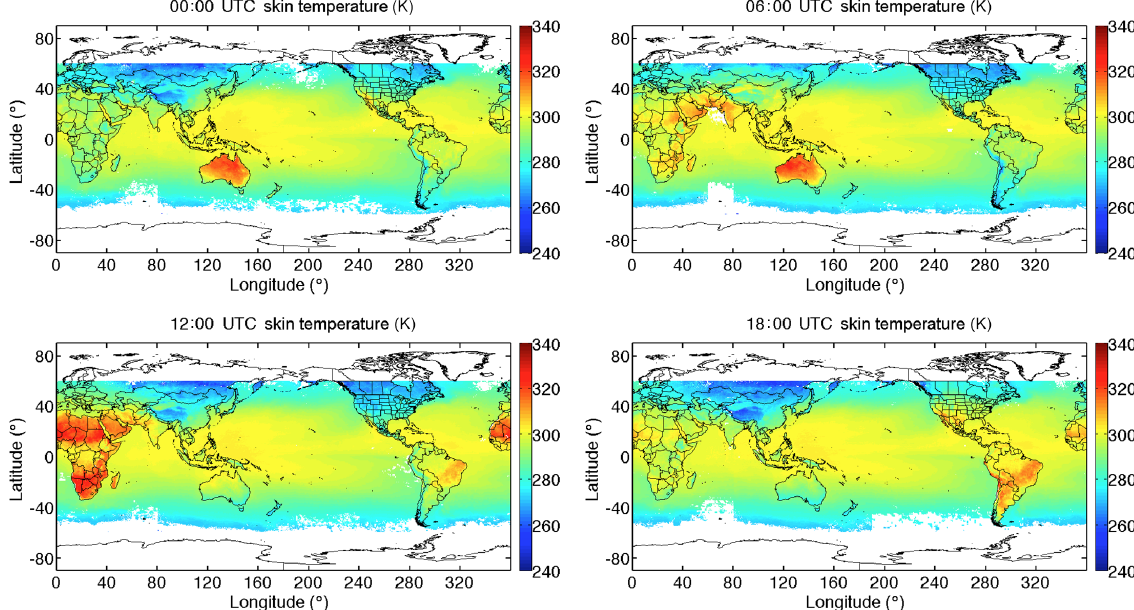
Figure 1. Mean merged, clear-sky surface skin temperature values from GOES-East, GOES-West, Meteosat-9, MTSAT-2, and INSAT-3D, October